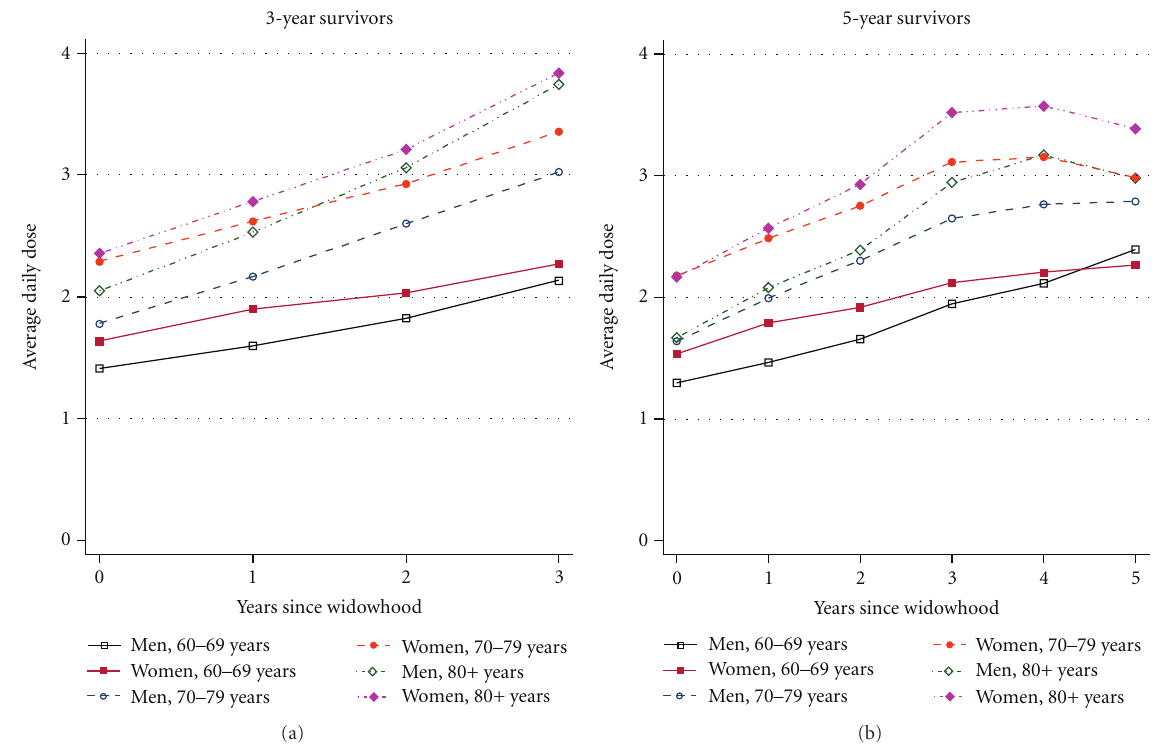
Figure 3: All-cause medication use among 3- and 5-years